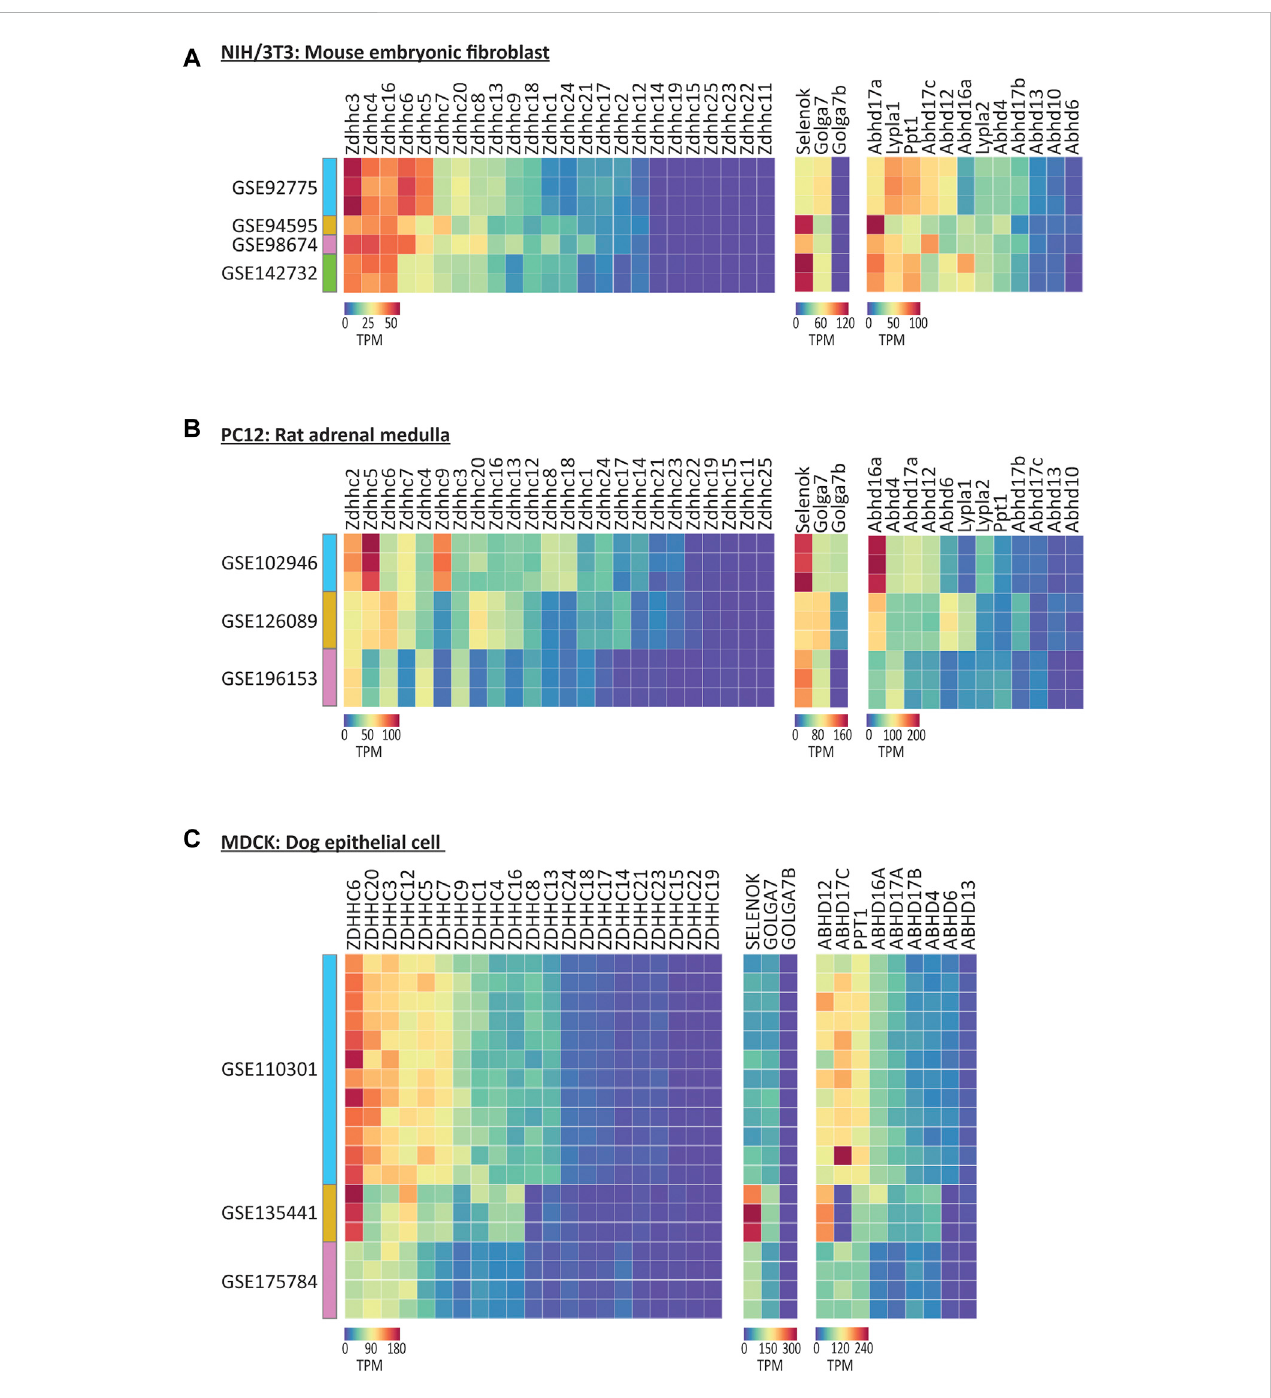
FIGURE 5 ExpressionofthegenesthatregulateS-palmitoylationinselectedcommonlyusednon-humancelllines. (A) HeatmapofRNAseqexpressiondataforthe genes that regulate S -palmitoylation in control/untreated samples from mouse NIH/3T3 cell line, downloaded from selected datasets on GEO (labelled with GEOaccessionnumbers). N =1 – 3controlsamplesperdataset.Units=Transcriptspermillion(TPM). (B) AsAbut forRatPC12celllinesamples. N =3samples per cell dataset. (C) As A but for dog MDCK cell line samples. N = 3 – 12 samples per